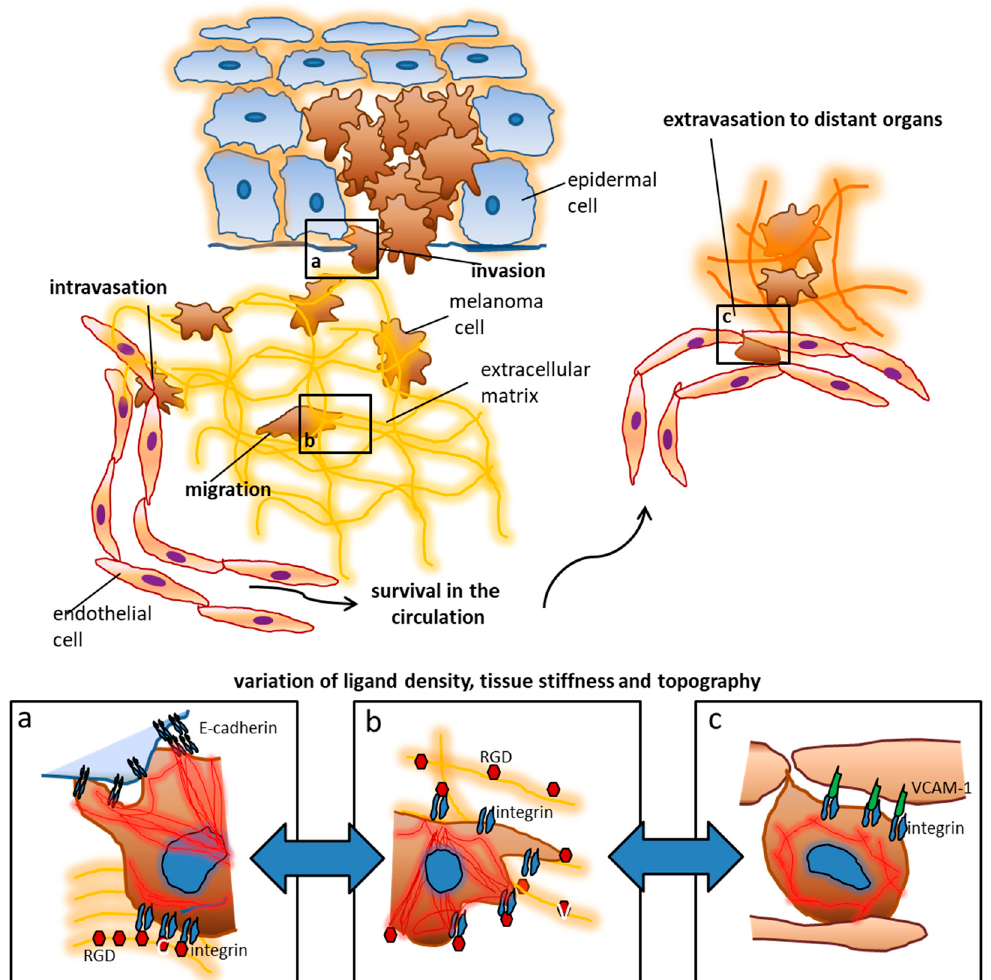
Figure 1. The extracellular matrix and stromal cells influence the behavior and fate of tumor cells. Using melanoma as an example, early tumor stages are controlled by contact with keratinocytes, which is mediated by cadherins and other surface receptors. During invasion, melanoma cells reach the extracellular matrix where they encounter additional ligands like RGD (arginine, glycine, aspartate) motifs in different arrangements. These ligands enable migration towards blood vessels and lymphatics. Upon intravasation tumor cells become exposed to new biophysical influences including shear and tensile forces by the blood flow. Adhesion ligands in distant organs like Vascular Cell Adhesion Molecule (VCAM)-1 lead to adhesion and tumor cell arrest which is a prerequisite for extravasation and metastasis formation. The colonization of distant organs requires the tumor cells to deal with very different ECM (extracellular matrix) conditions which include tissue stiffness, ligand density, and topography. The panels a–c depict some examples of tumor cell interactions which can be addressed by nanotechnological approaches: ( a ) when tumor cells leave their original tissue, cadherin interactions are presumably involved. Changes in the cadherin repertoire as well as the density and topographical arrangement of the ligand presentation play an important role according to our current knowledge. Upon contact with high densities of RGD, melanoma cell spreading is inhibited, while E-cadherin (largely irrespective of its density) enhances spreading. ( b ) In the ECM of the connective tissue, integrins and gradients of their ligands are particularly responsible for motility, morphogenesis, and spread of tumor cells. These functions are for example clearly controlled by RGD residues. Melanoma cells entrapped in an ECM with reduced RGD ligands show maximum spreading possibly enhancing migration. ( c ) It is assumed that VCAM-1 density plays an important role in the extravasation of melanoma cells at sites of metastasis formation, whereby higher VCAM-1 densities can inhibit the spreading of tumor cells.